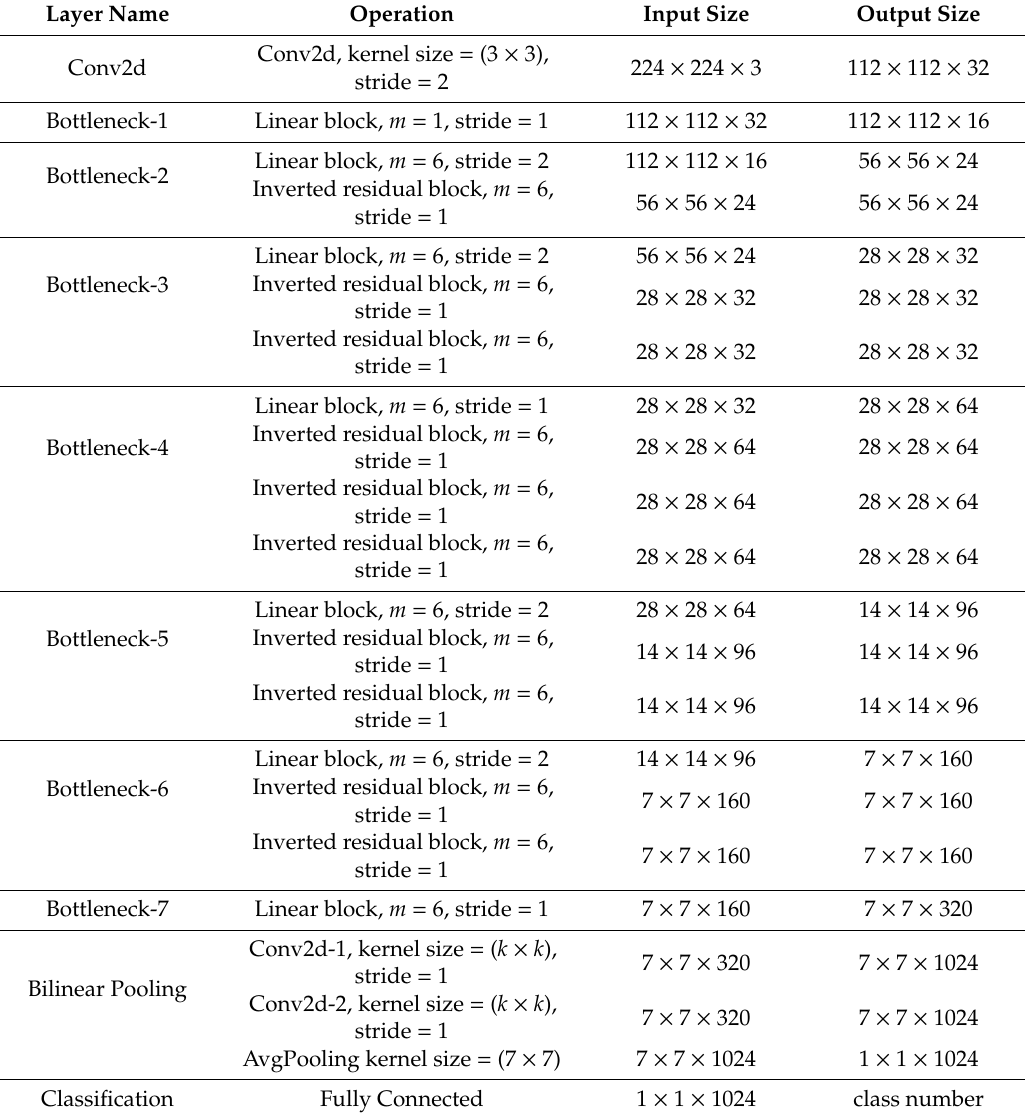
Table 2. BiMobileNet